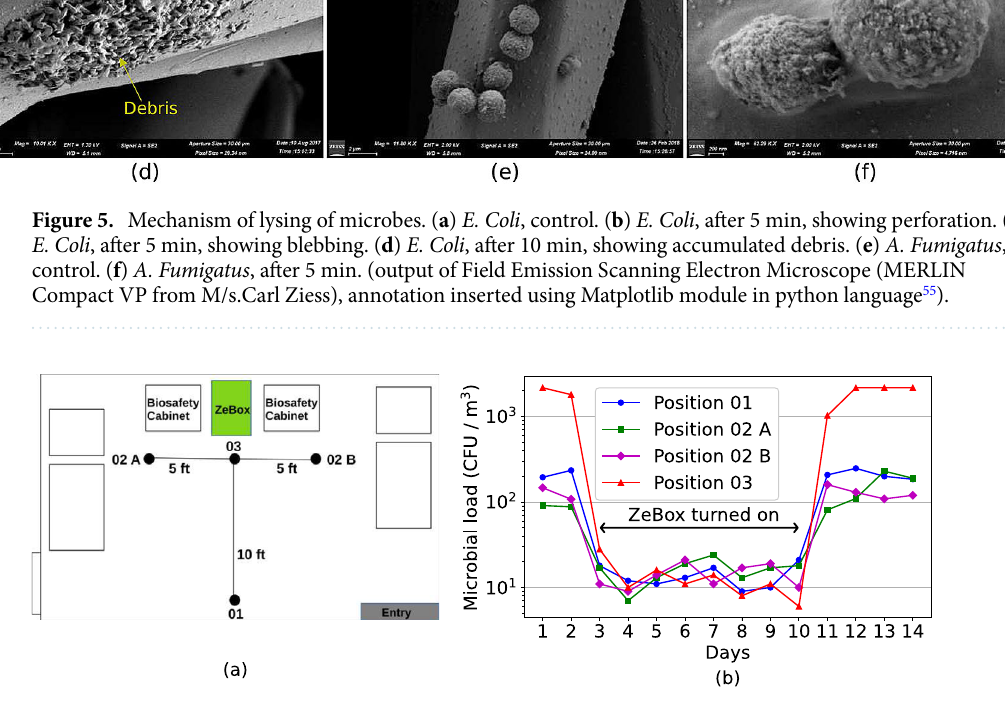
Figure 6. Microbial load reduction in field experiment. ( a ) Setup of the field experiment. Measurement locations are indicated by filled circles in the schematic. ( b ) Reduction in the microbial load. ( a created using LibreOffice Draw (https:// www. libre office. org), b created using Matplotlib module in python language 55